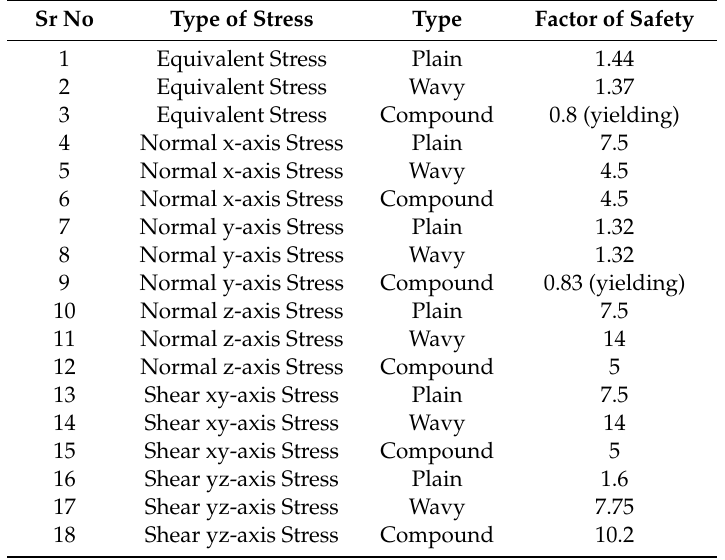
Table 4. Factor of safety along path 2 for plain, wavy and compound